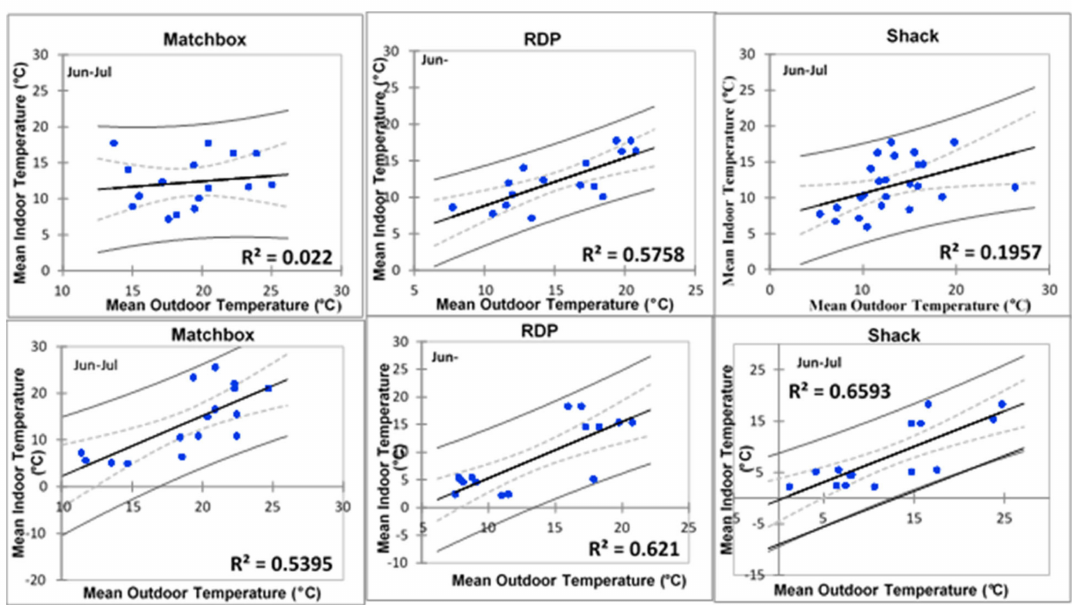
Figure 12. Regression models of the three types in Kathorus (top row) during colder months, with a confidence interval of 95% (d.f. = 1).